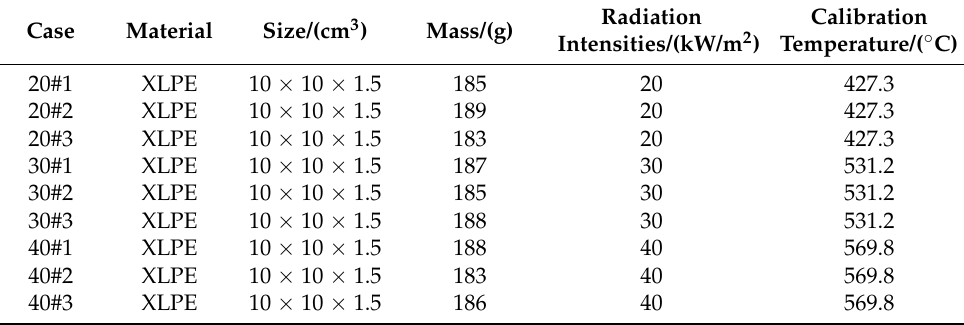
Figure 2. Cable arrangement. Table 1. XLPE radiation ignition condition setting and